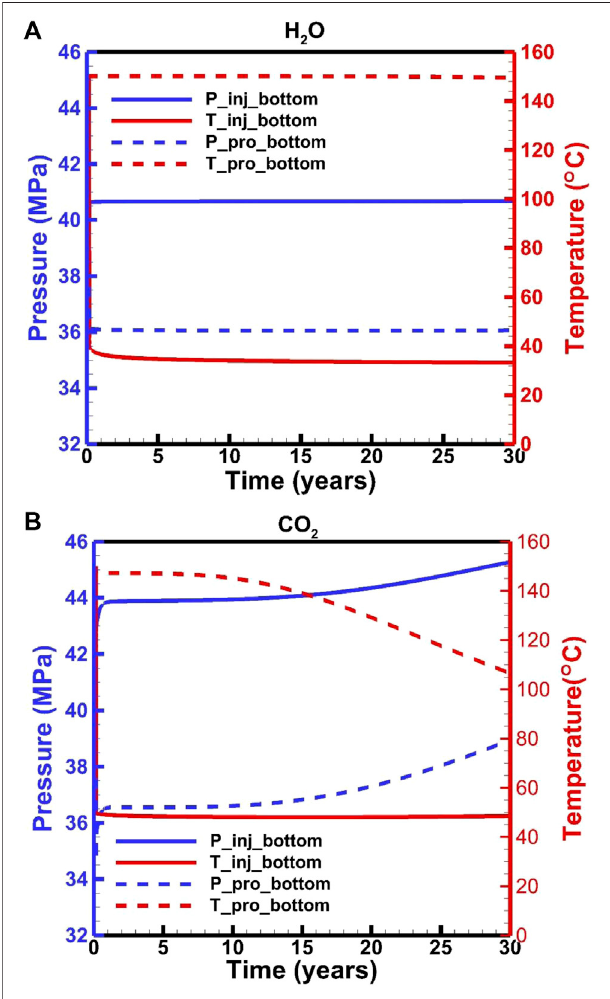
FIGURE 4 | Downhole pressure and temperature for (A) the H 2 O-based and (B) CO 2 -based EGS.